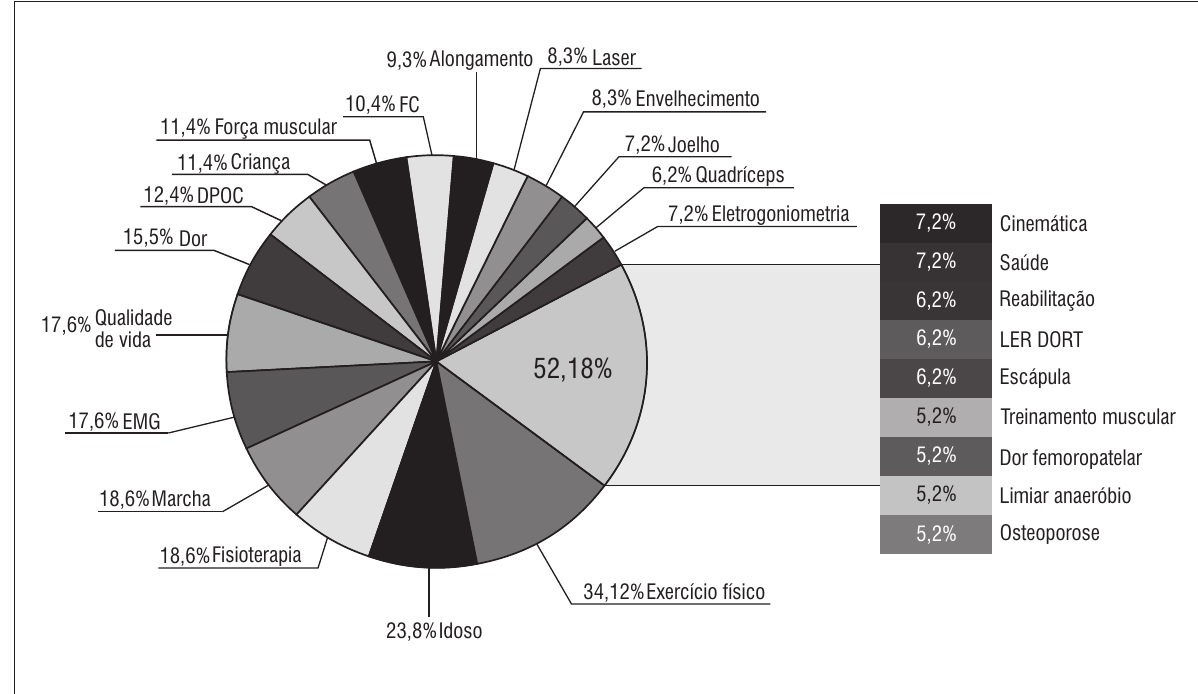
Gráfico 1 - Gráfico representativo da frequência ( % ) e ocorrência (número de vezes) das palavras-chave nos estudos analisados Nota: Destaca-se um cuidado na leitura deste grá fi co: a área cinza clara, 52; 18%, representa o somatório dos percentuais que seriam muito pequenos para serem representados individualmente no grá fi co pizza. Fonte: Dados da